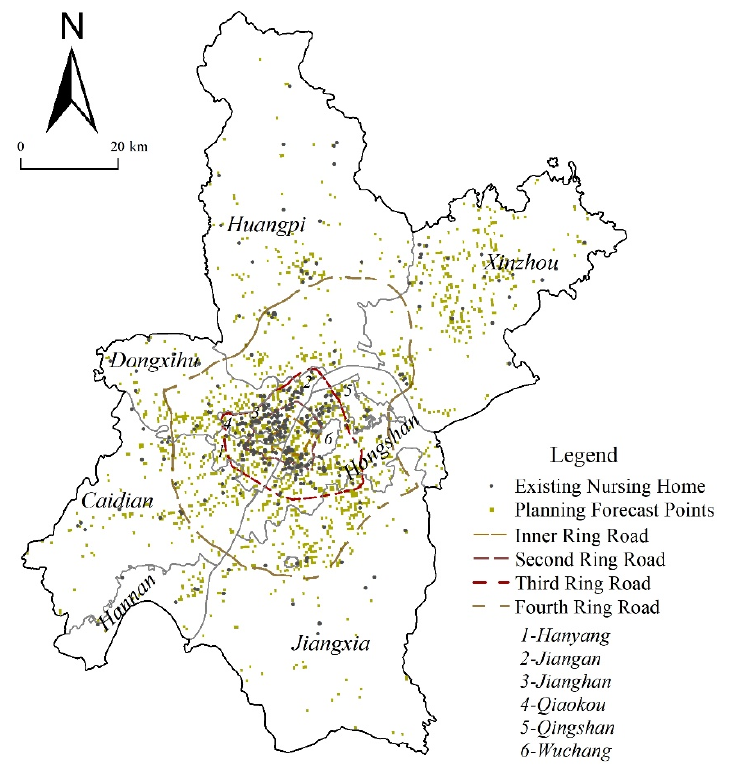
Figure 4. Initial areas for the new urban elderly care facilities at the street level in Wuhan, China.